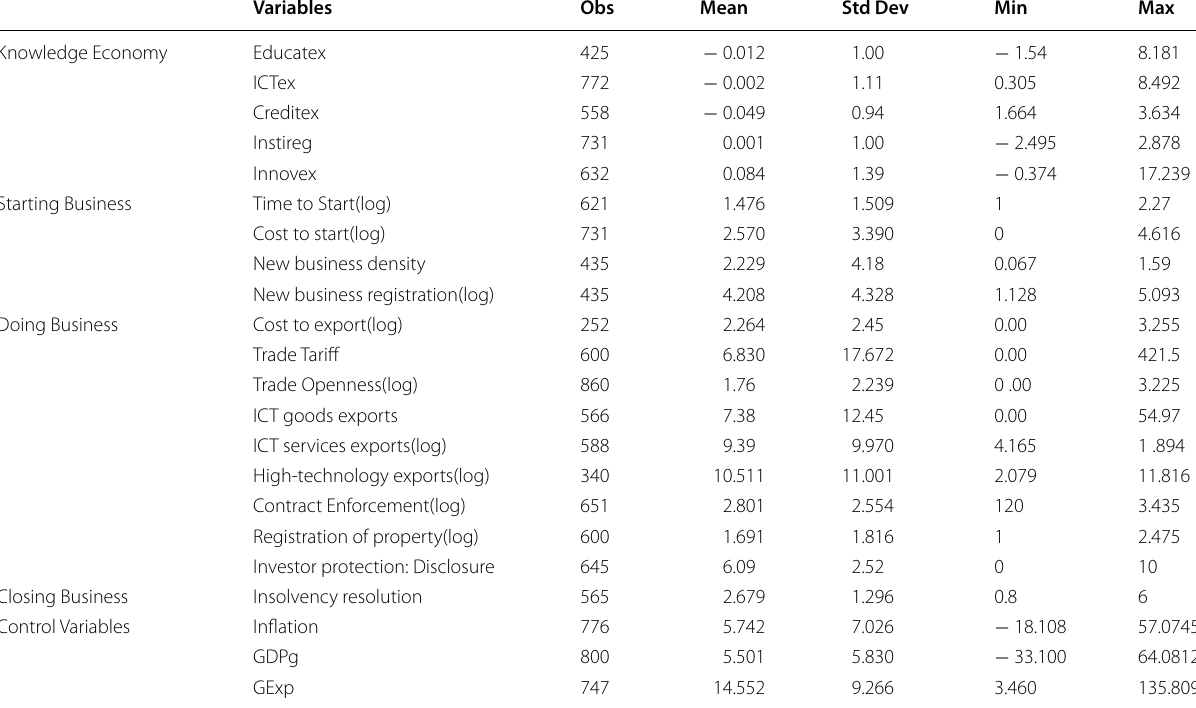
Table 1 Summary statistics of Asian